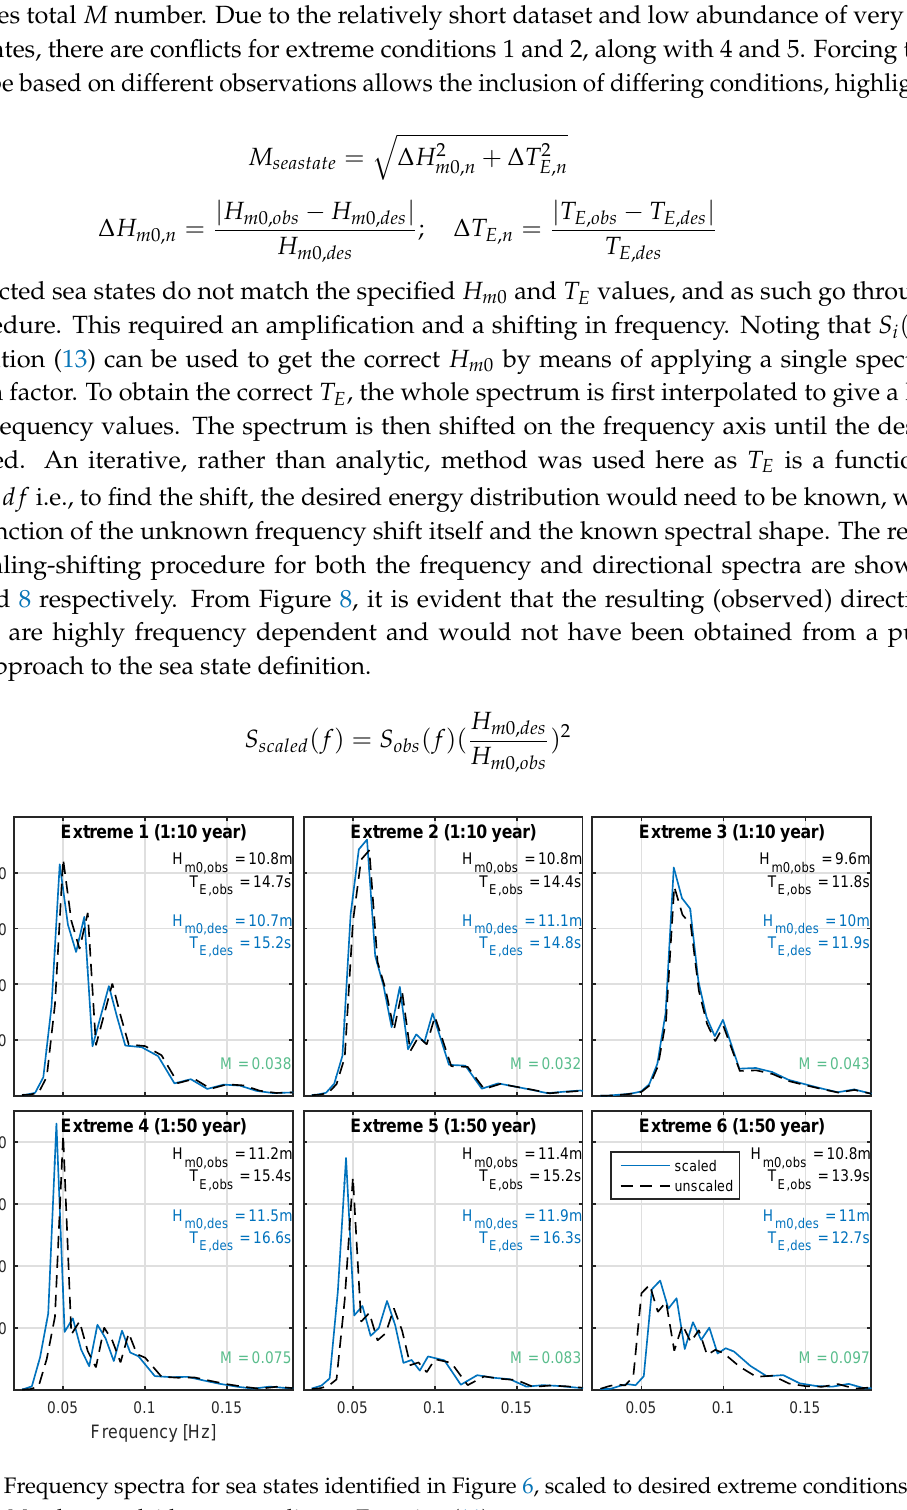
Figure 7. Frequency spectra for sea states identified in Figure 6, scaled to desired extreme conditions (Table 1). M value overlaid corresponding to Equation